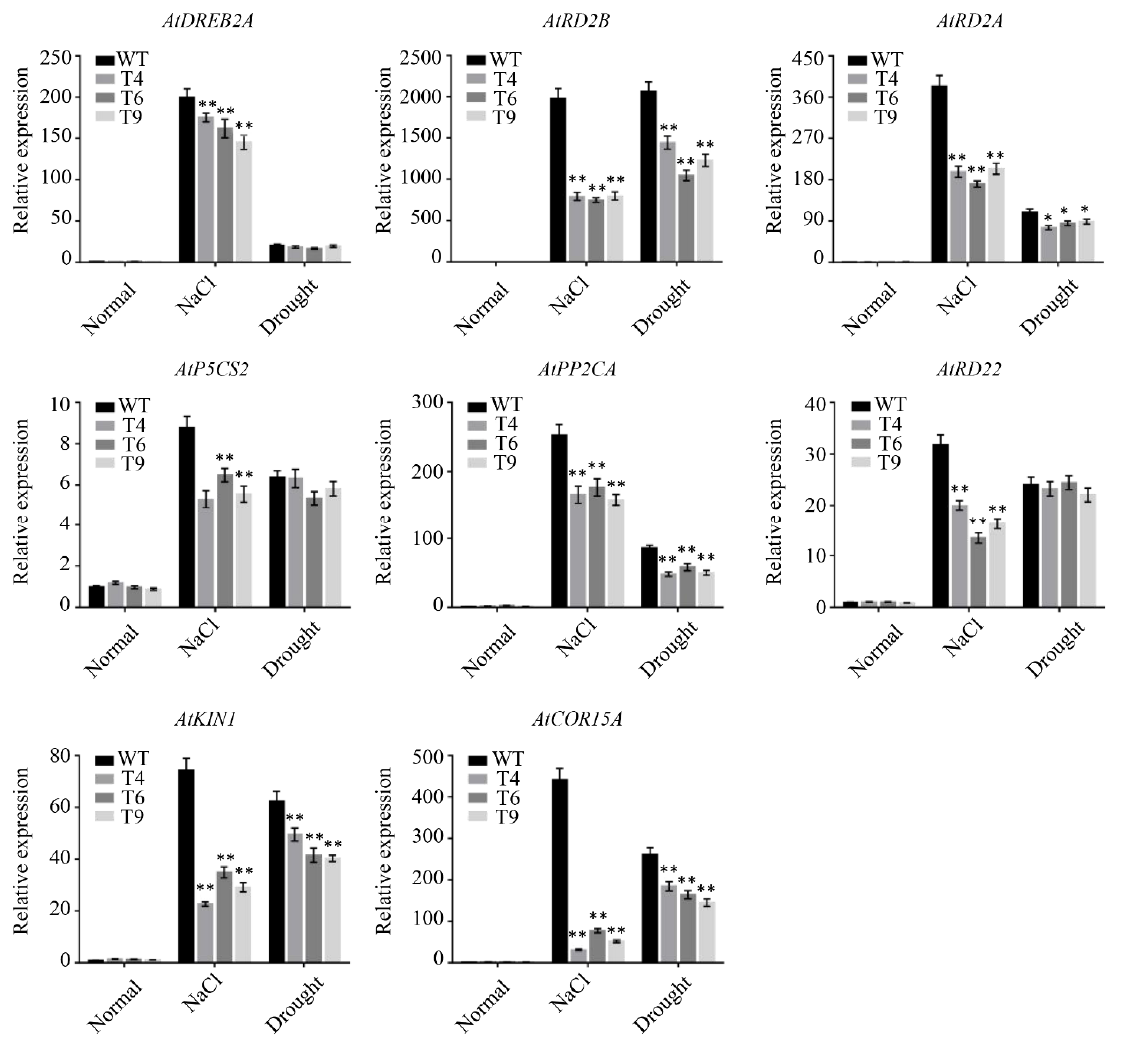
Figure 11. Expression levels of stress-associated genes following overproduction of FtMYB22 in Arabidopsis (T4, T6, and T9) lines and WT lines under stress treatments. Normal: under normal condi- tion. WT, wild-type. Data are presented as mean and SD values of three independent experiments. Error bars indicate SD. ** means extremely significant difference at p < 0.01 level. * means significant difference at p < 0.05